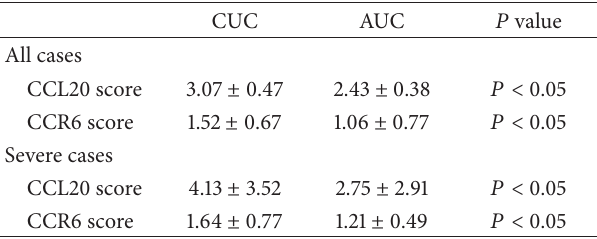
Table 3: The comparison of CCL20 and CCR6 expression between CUC and